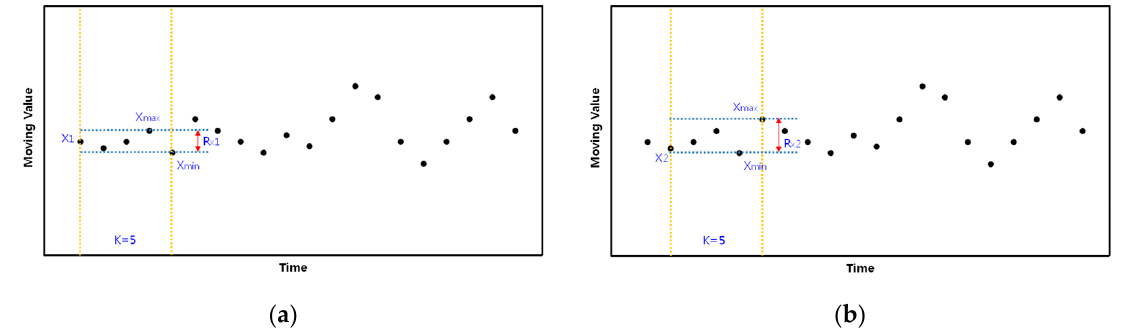
= 1 ( b ) Calculation of R xi at i